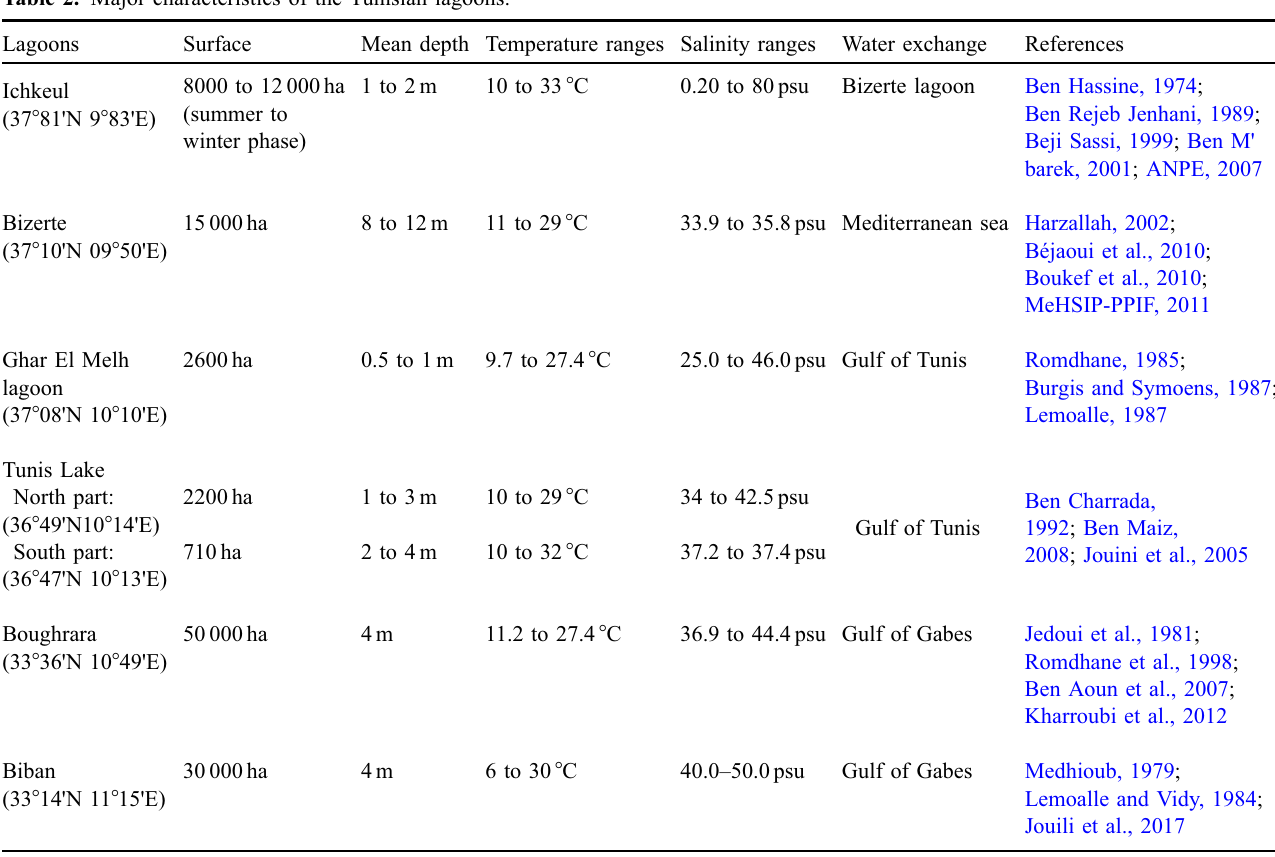
Table 2. Major characteristics of the Tunisian